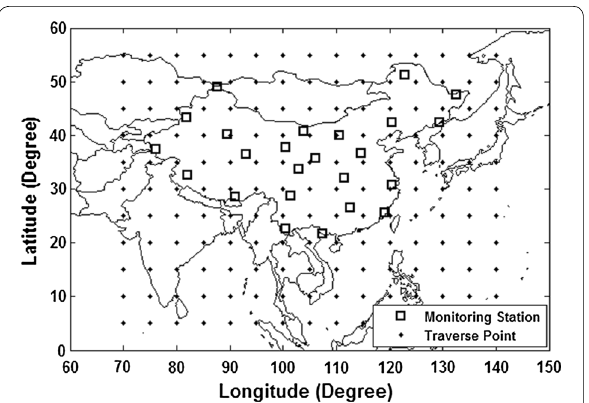
Fig. 4 Distribution of the selected monitor stations in